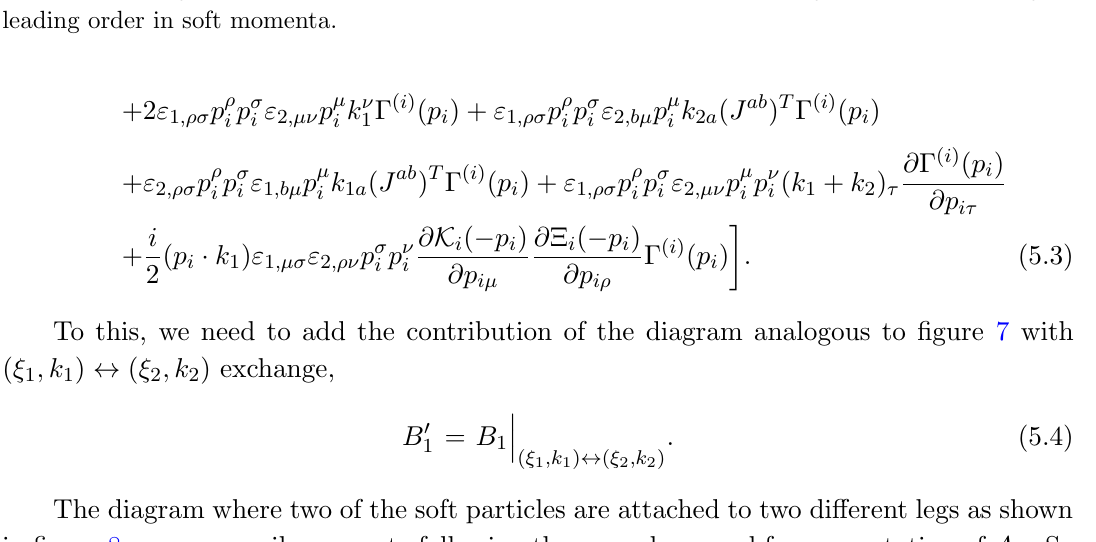
Figure 8 . Diagram with two soft particles attached to two di(cid:11)erent legs start contributing at leading order in soft